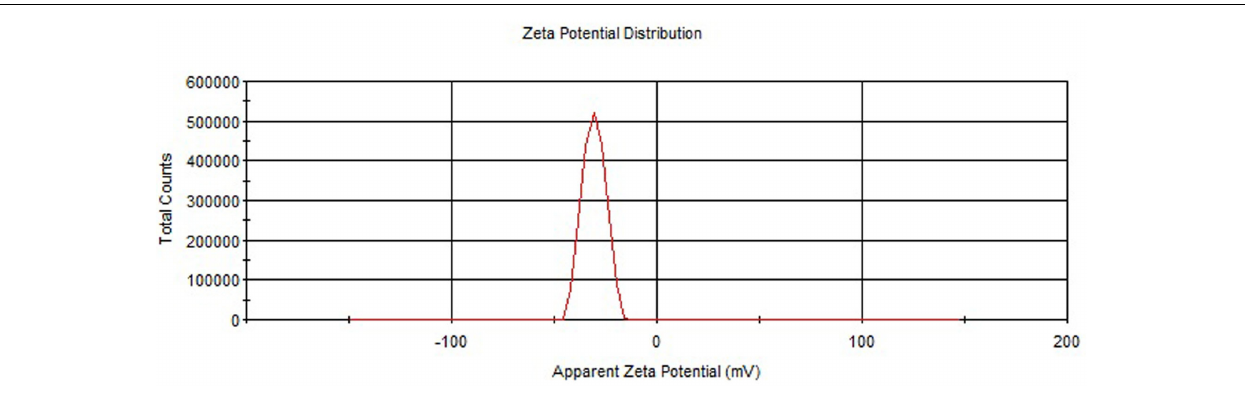
FIGURE 2 | Zeta potential of Eudragit coate PLGA